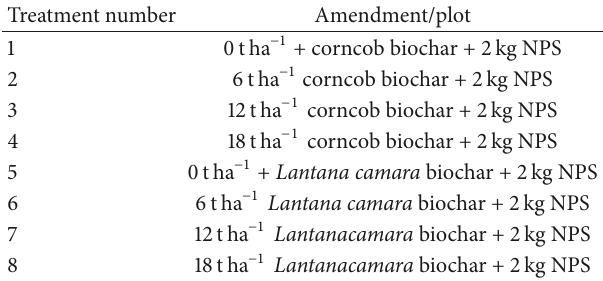
Table 1: Treatment used in experimentation. Treatment